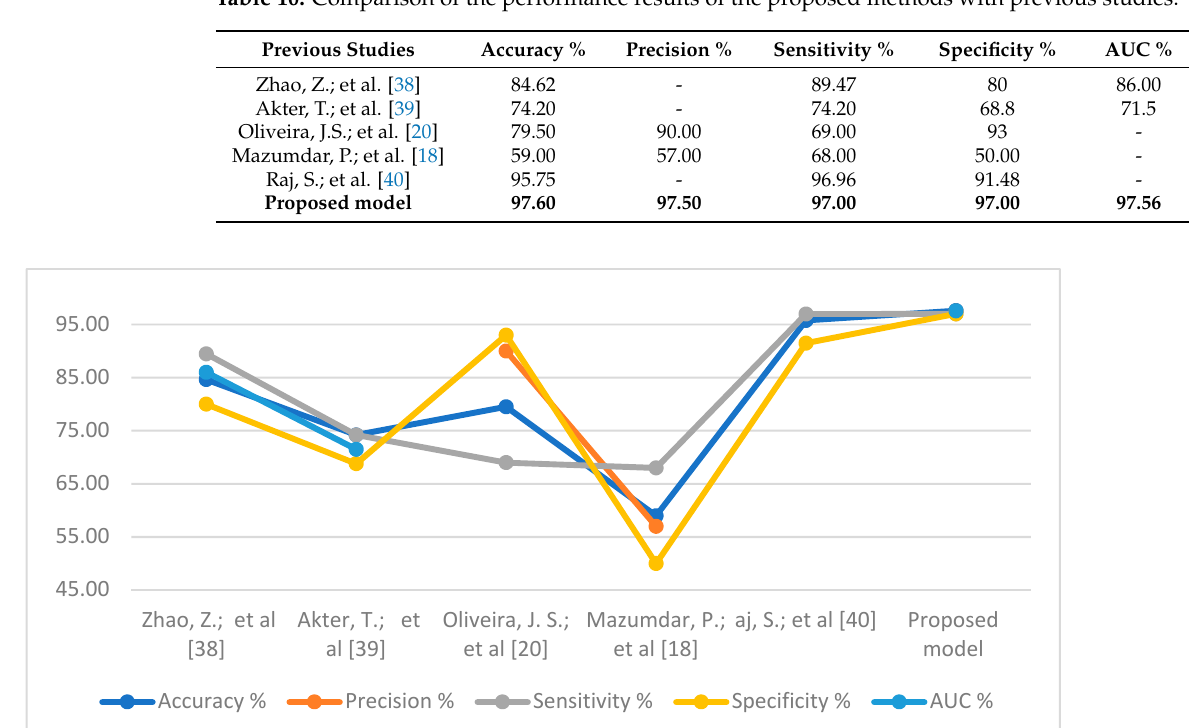
Table 10. Comparison of the performance results of the proposed methods with previous studies.